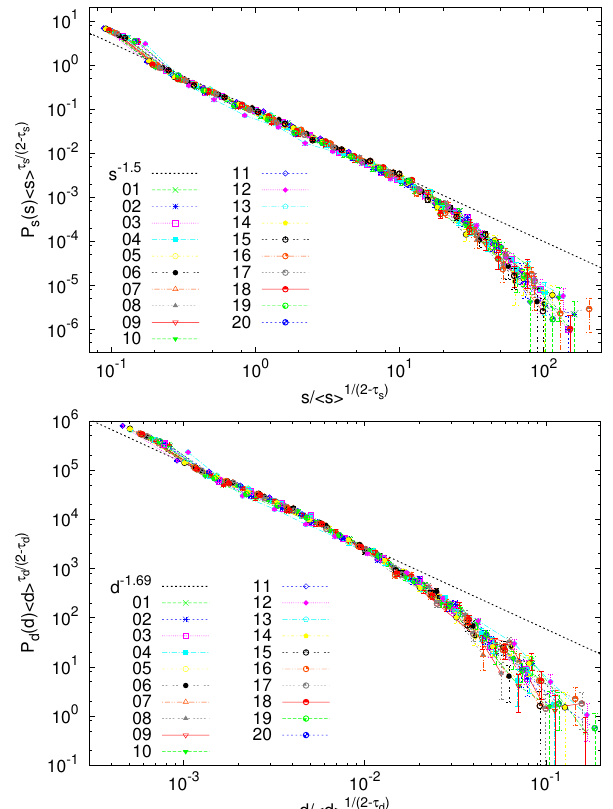
Fig. 4. Collapse of the probability densities for all the sites for the whole time covered by the record of (a) event sizes and (b) event durations; rescaled using Eq. (6) with the exponents: τ s = 1 . 52 and τ d = 1 . 69, determined minimizing the Euclidean distance between parametrically collapsed distributions. Units are mm or min to the corresponding powers appearing in the